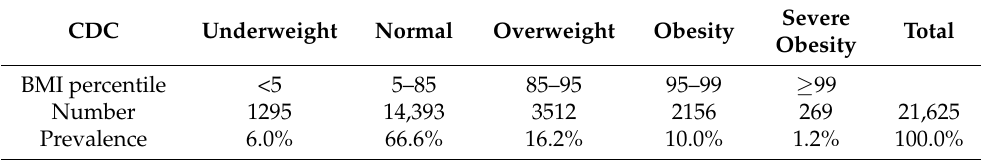
Table 5. Prevalence of underweight, overweight, obesity and severe obesity using CDC